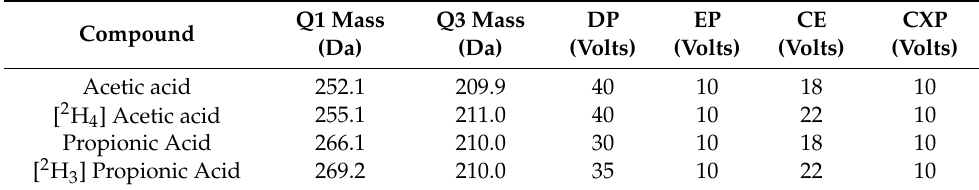
Table 1. Mass spectrometry